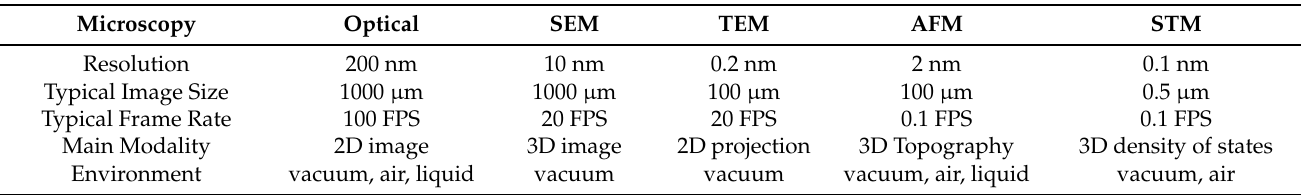
Table 1. Comparison of Main Microscopy